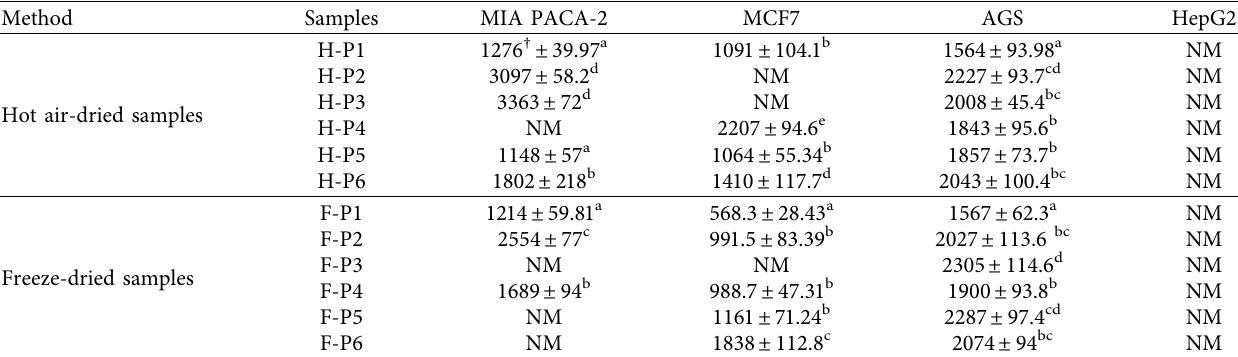
Figure 5: Antiproliferative effects of methanol extracts of cabbage leaf layers as assessed by the MTTassay following 48h of exposure to the MIA PaCa-2 cell line, (a) MCF7 cell line, (b) AGS cell line, (c) and HepG2 cell line (d). The mean and standard deviation were obtained from three independent experiments. H-P1, hot air-dried part 1; H-P2, hot air-dried part 2; H-P3, hot air-dried part 3; H-P4, hot air-dried part 4; H-P5, hot air-dried part 5; H-P6, hot air-dried part 6; F-P1, freeze-dried part 1; F-P2, freeze-dried part 2; F-P3, freeze-dried part 3; F-P4, freeze-dried part 4; F-P5, freeze-dried part 5; F-P6, freeze-dried part Table 3: IC 50 ( μ g/mL) values of methanol extract cabbage leaf layers.